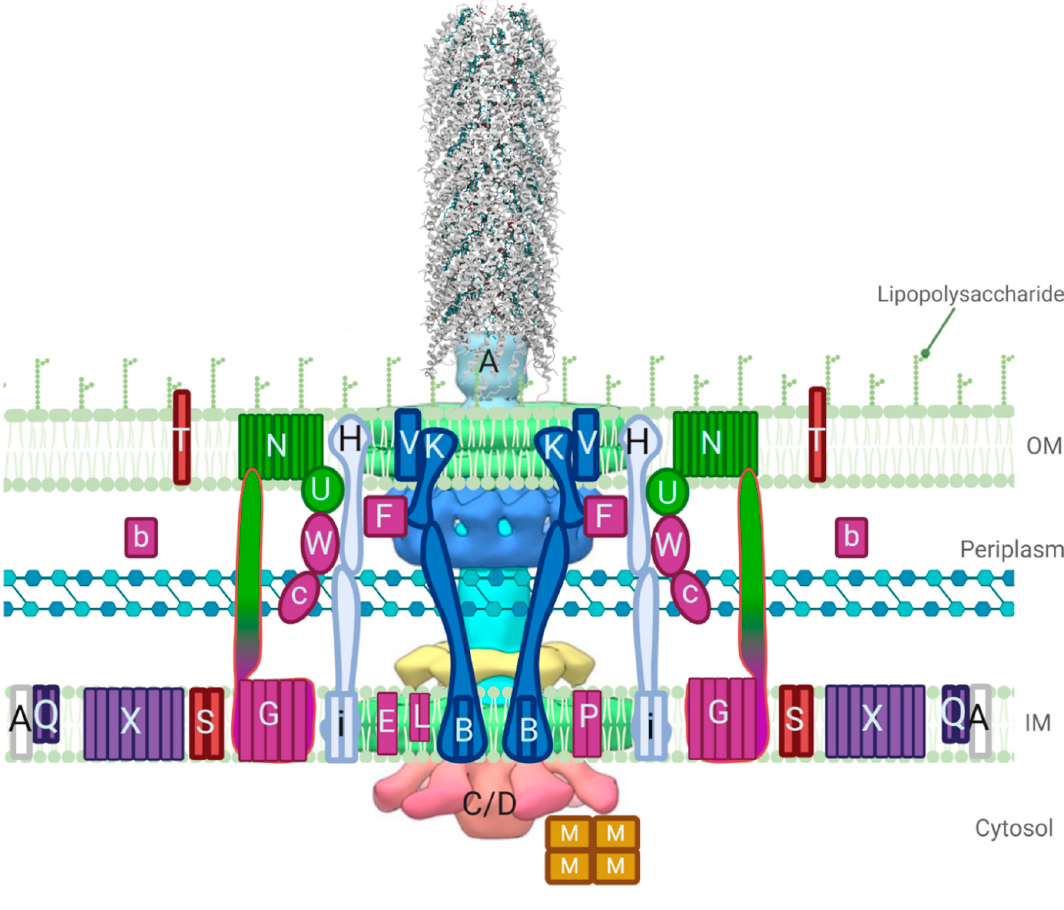
Figure 1. A model of the F-like type IV secretion systems (T4SS) based on available structural information, including a cryo-electron tomography (cryo-ET) model of the pED208 core complex and a cryo-electron microscopy (cryo-EM) model of the assembled pED208 pilus (PDB ID: 5LEG) [15,16]. Tra proteins are labeled with capital letters and Trb proteins are shown with lower case letters. Proteins are colored based on function; the pilin TraA is white, pilin processing proteins are purple, proteins responsible for pilus assembly / extension are colored in fuchsia, the core complex is colored in dark blue, while pilus retraction proteins are colored in light blue, green colored proteins are responsible for mating pair stabilization, and the red proteins are responsible for exclusion. ATPase proteins TraC and TraD are complexed in the cytosol based on the cryo-ET image, but are present in the inner membrane (IM) as well. The outer membrane (OM) complex in blue is composed of TraK and TraV in a complex that creates 13-fold symmetry. Figure created with BioRender.com.